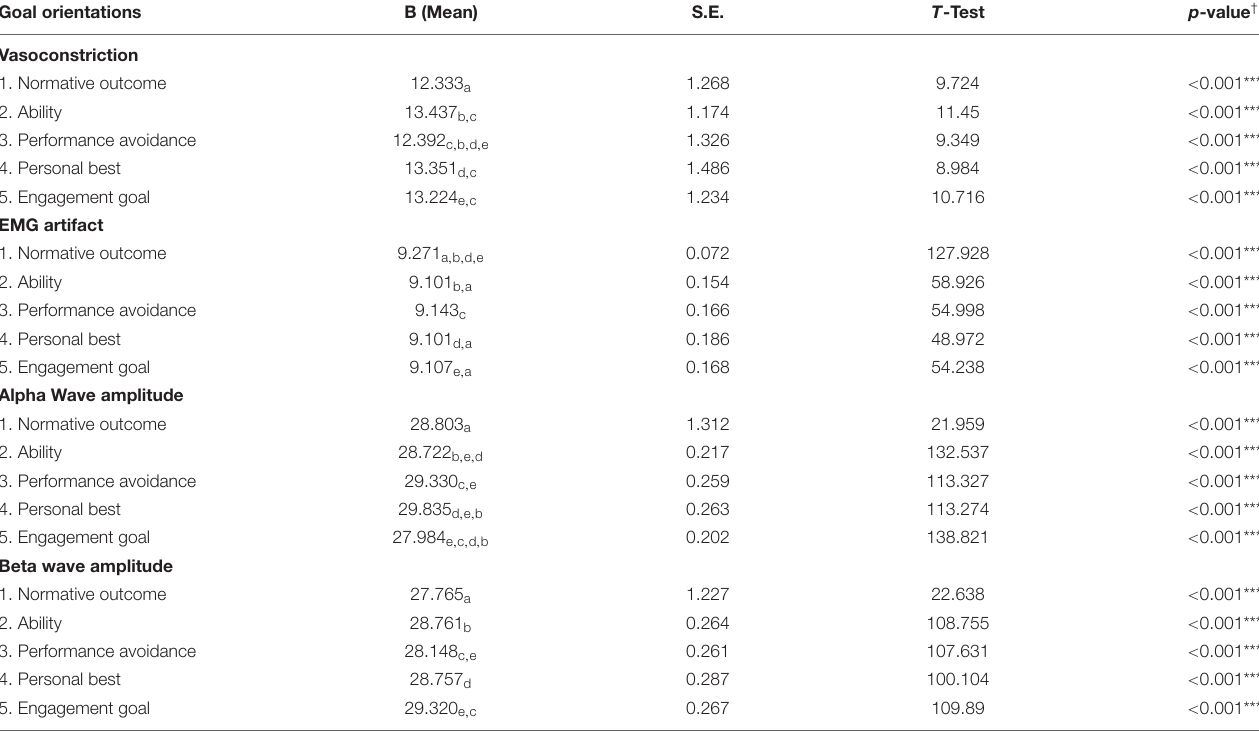
TABLE 2 | Results from the multilevel model for the prediction of vasoconstriction, EMG artifact, and alpha and beta amplitude as a function of goal orientations. Goal